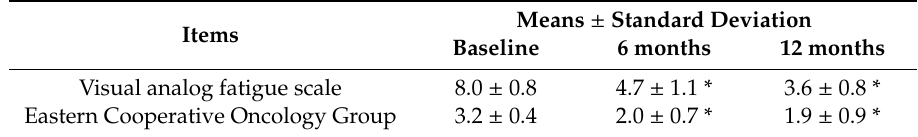
Table 3. Visual analog fatigue scale and Eastern Cooperative Oncology Group values after autologous immune enhancement therapy